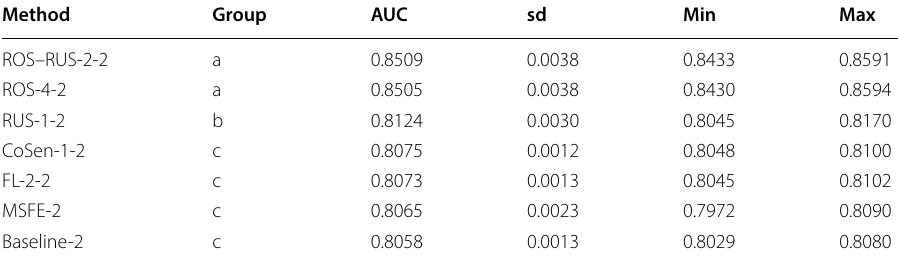
Table 20 Tukey’s HSD test results (AUC) Method Group